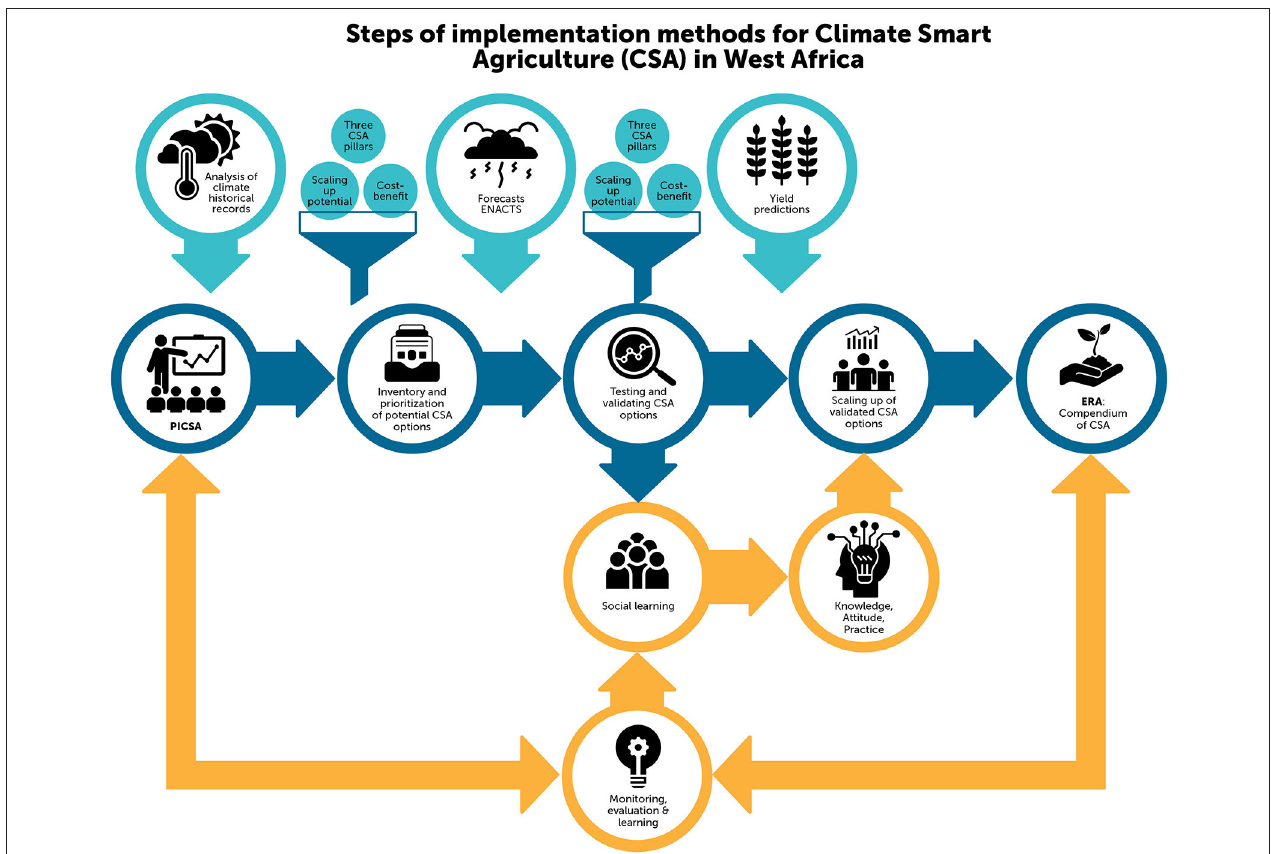
FIGURE 2 | Framework for selecting and implementing CSA approaches in West